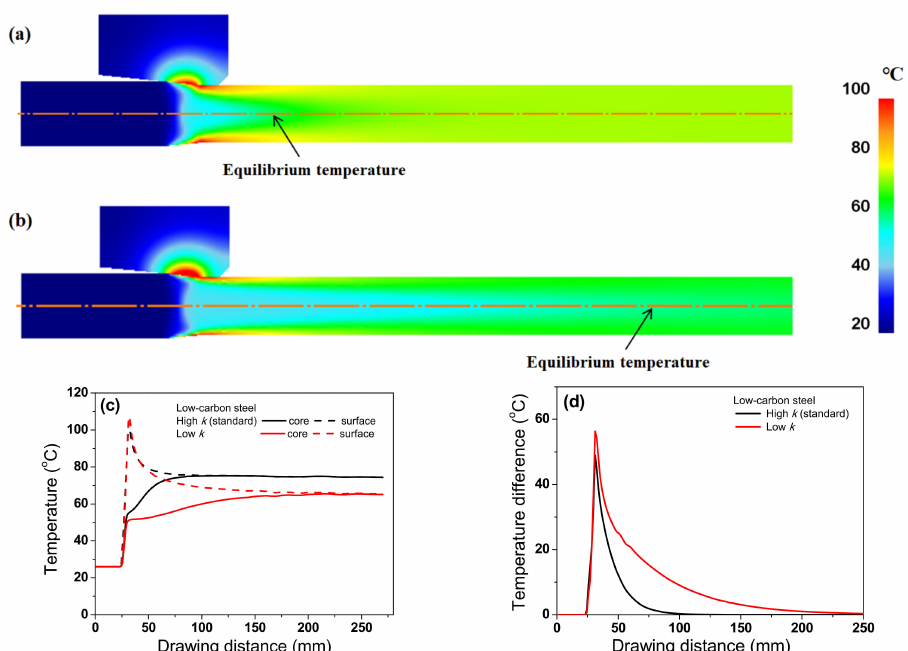
Figure 13. Comparison of temperature contour of low-carbon steel with ( a ) standard and ( b ) low thermal conductivities. Comparison of ( c ) temperature profiles along the drawing direction at core and surface regions and ( d ) temperature difference between core and surface regions of low-carbon steel.